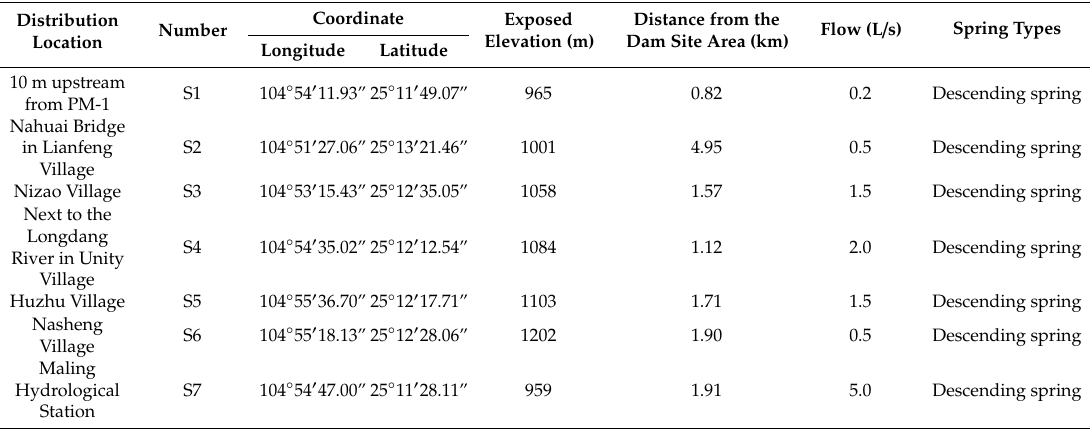
Table 5. Exposure of spring water around the study